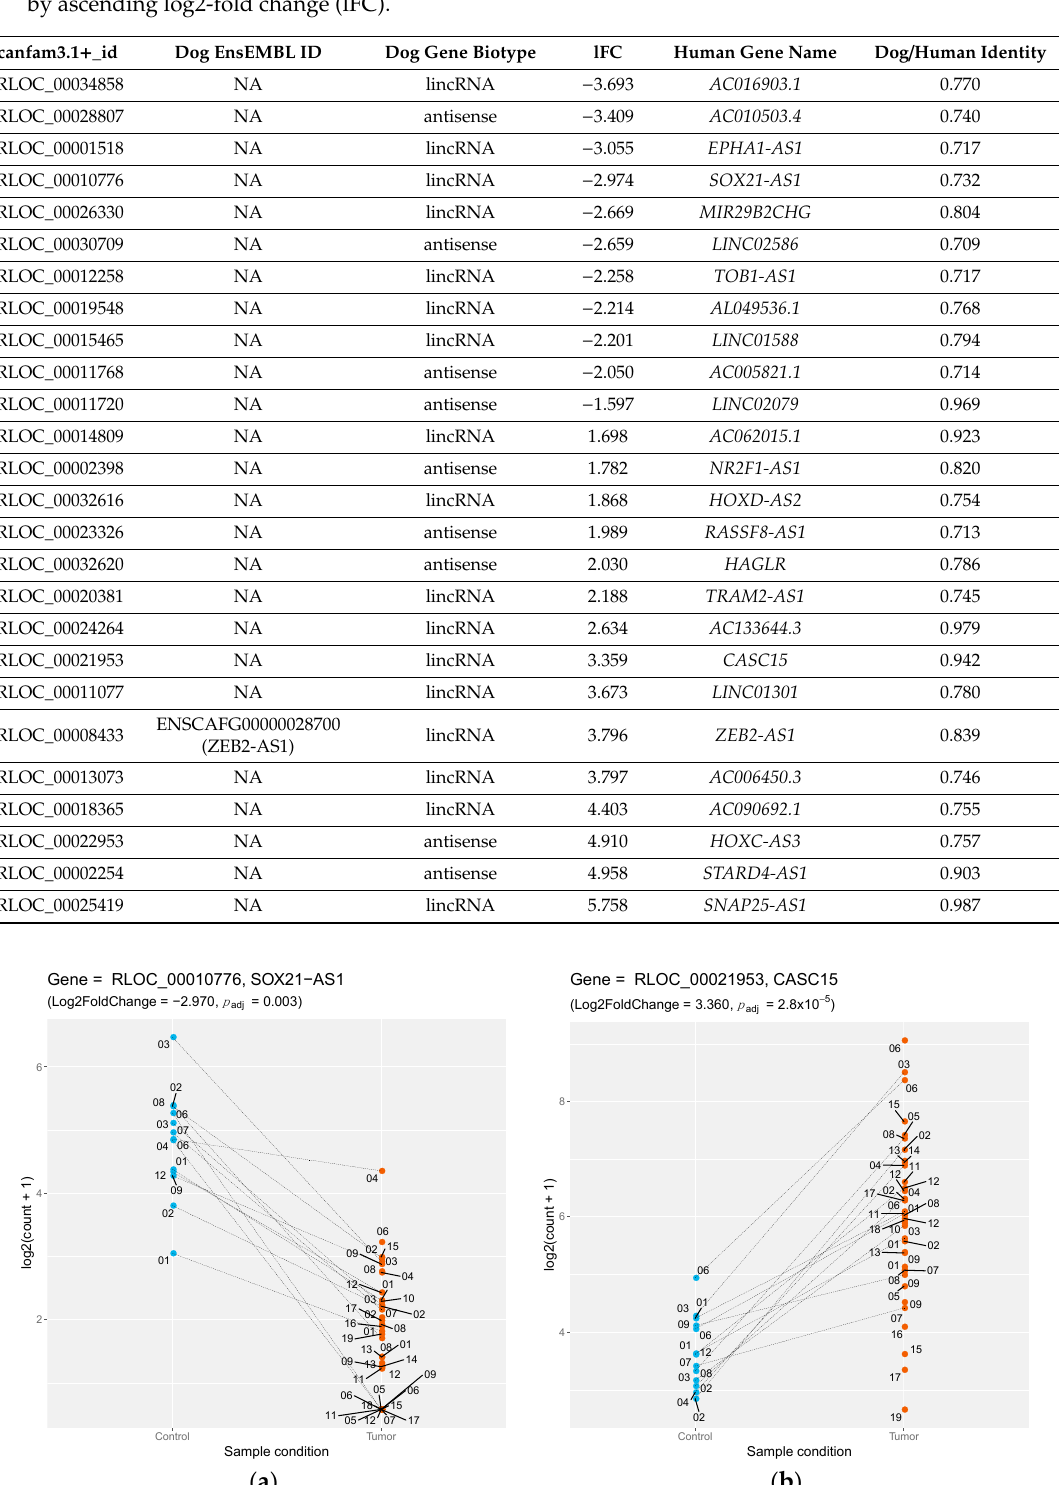
Table 1. List of DE lncRNAs conserved with human GENCODE non-coding genes. Genes are ordered by ascending log2-fold change (lFC).